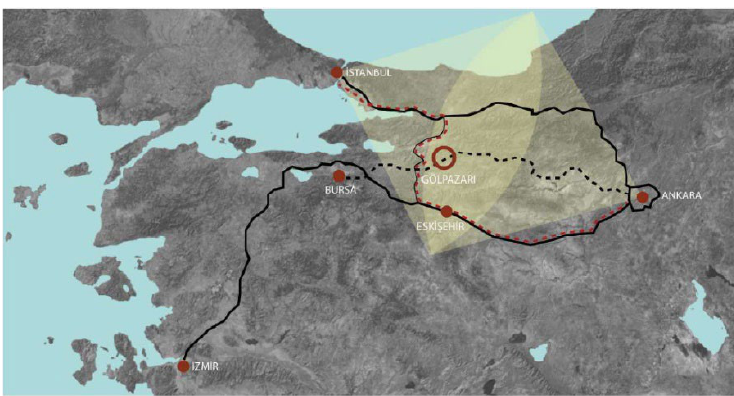
Figure 1 Geographic loca tion of Gölpazarı (Keep Your Village Alive